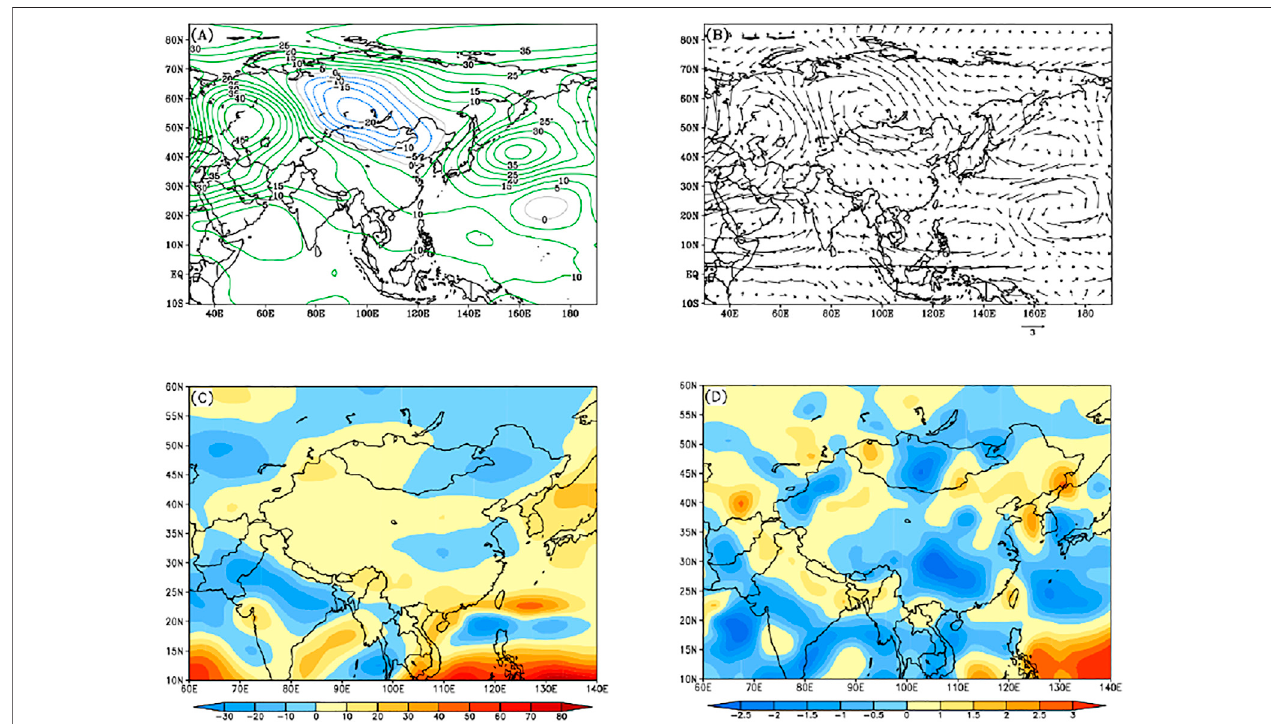
FIGURE 9 | Difference in (A) geopotential height, (B) wind at 500 hPa, (C) vertically integrated water vapor fl ux (surface to 300 hPa), and (D) vertically integrated water vapor fl ux divergence (surface to 300 hPa) during the year with the lowest concentration of extreme precipitation.